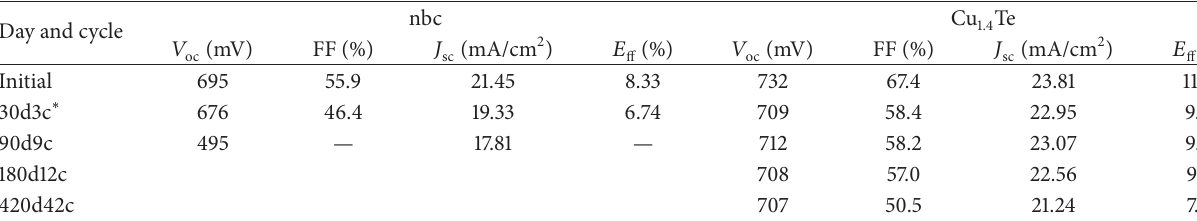
Table 3: Evolution of device parameters for CdTe solar cells with the temperature cycling.